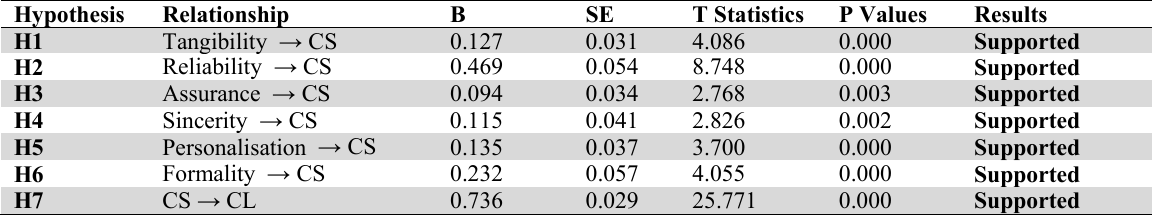
Results of Structural Model Analysis (Hypothesis